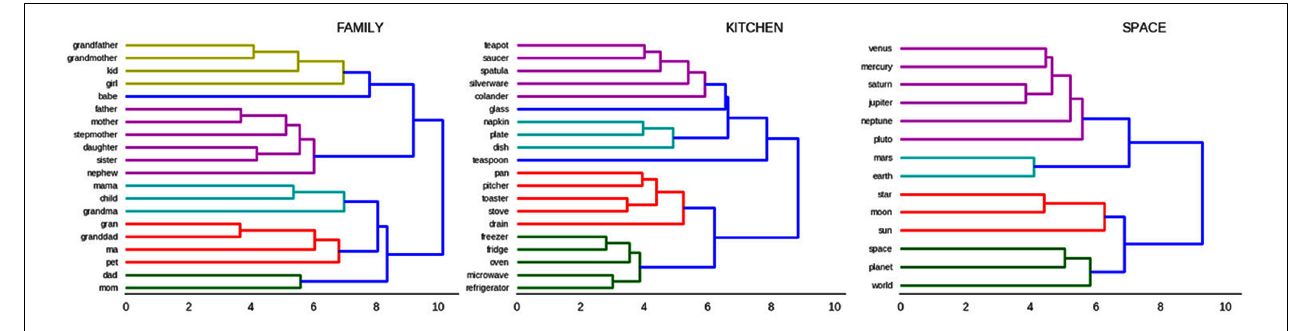
FIGURE 6 | Hierarchical clustering dendrogram of words in the categories “family members,” “kitchen items,” and “space.”